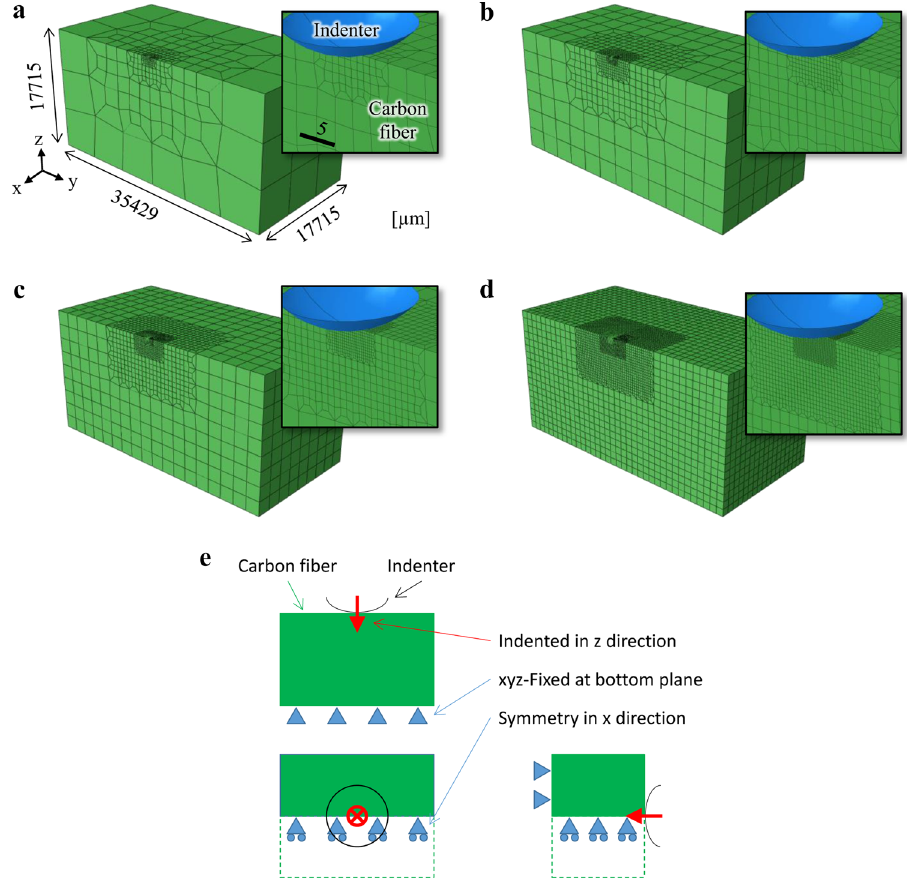
Fig. 2 Finite element models with minimum mesh sizes ( l ) of a 0.9, b 0.45, c 0.3, d FEA 0.15 µm, and e